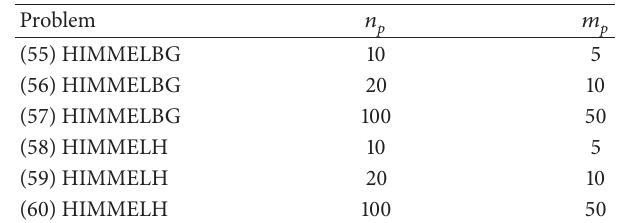
Table 2: The information about benchmark problems set 𝑃 2